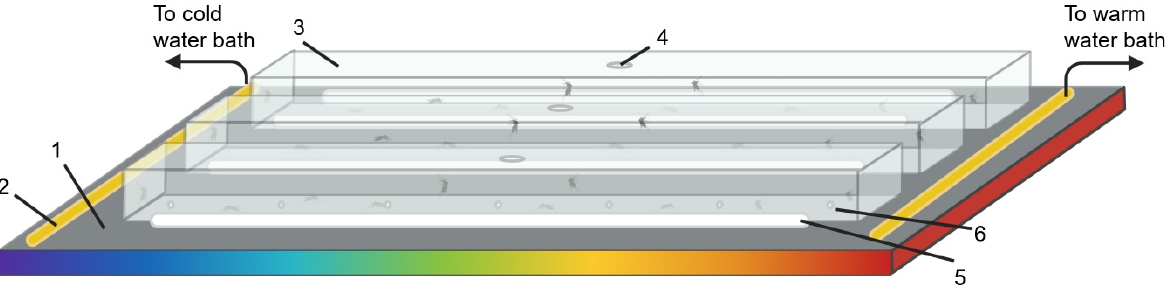
Figure 1. Schematic of the thermal gradient experimental setup. A temperature gradient was created on an aluminum plate (1) using a cold and a warm water bath on either side, connected with copper tubing (2). The mosquitoes were released into acrylic covers (3) through a hole in the top with a fitted acrylic plug (4). Each cover had moist wipe towels (5) and holes drilled on each side to minimize humidity build up (6). The acrylic enclosures are open on their bottom side to allow direct contact of mosquitoes with the aluminum plate.